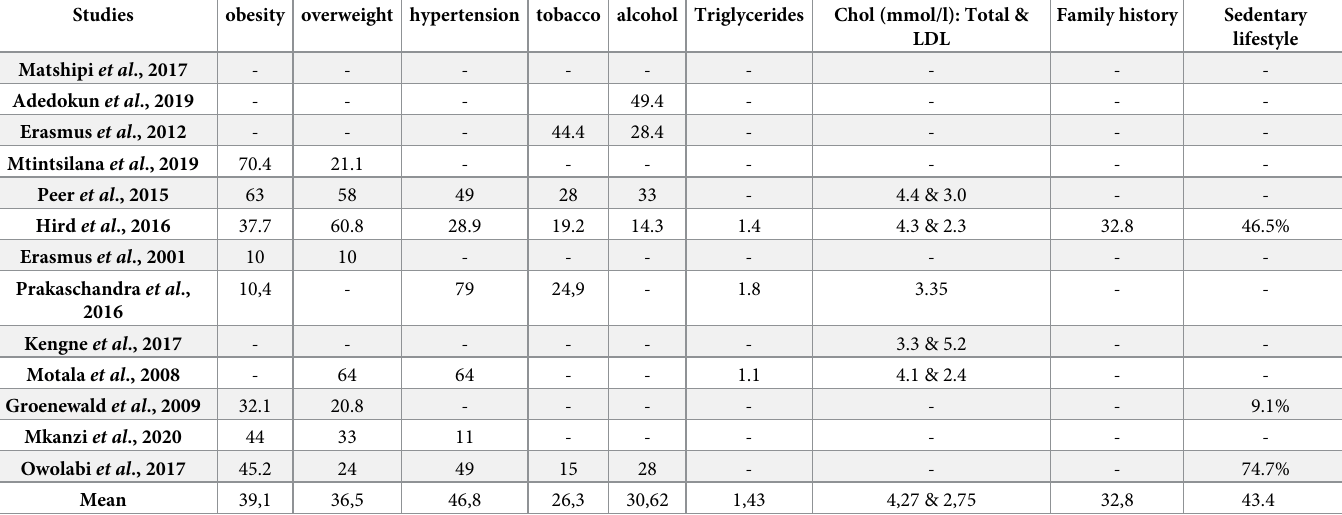
Table 2. Shows the proportion of risk factors associated with